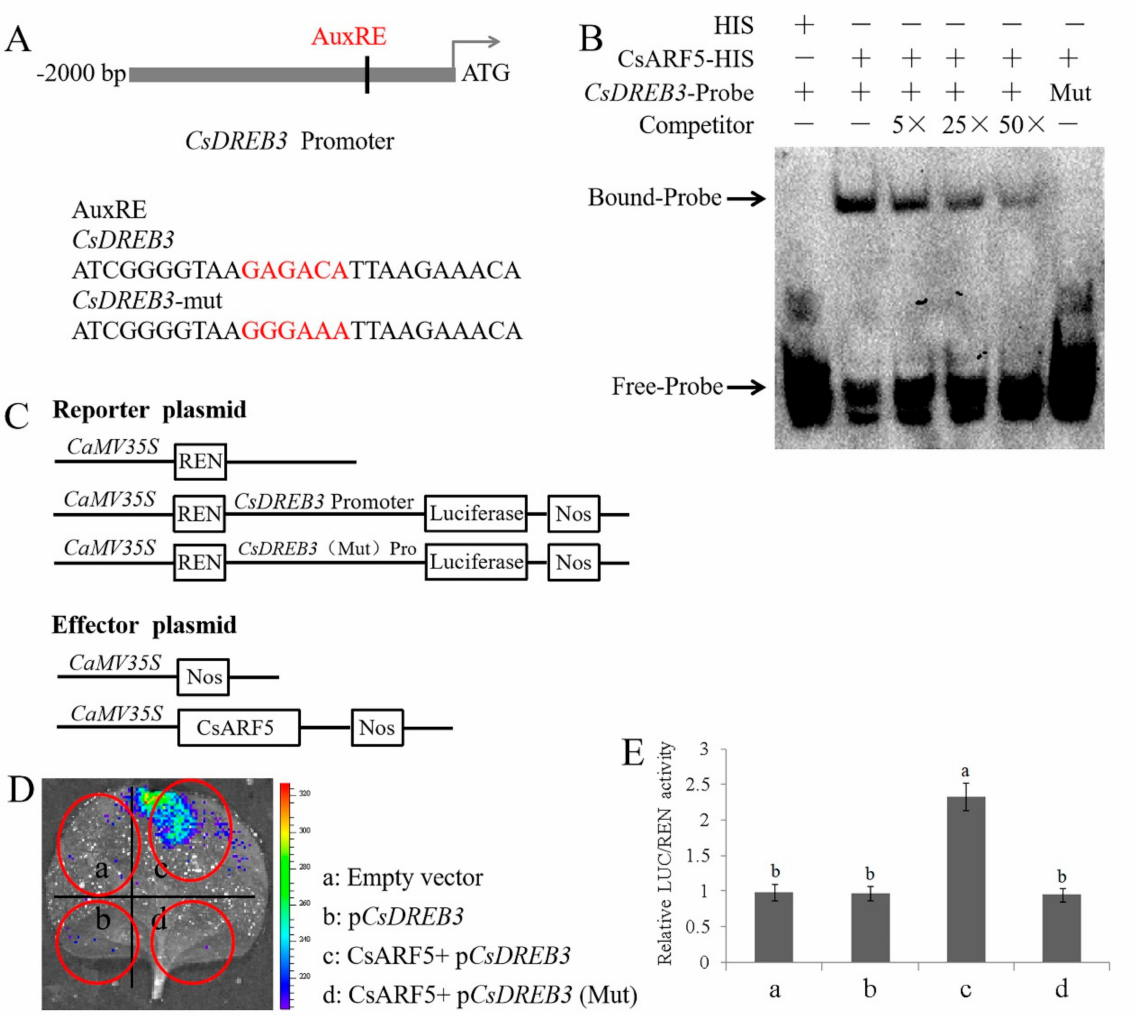
Figure 8. CsARF5 directly modulates the expression of CsDREB3 . ( A ) Schematic diagram showing the CsDREB3 promoter probe used for EMSAs. Mutated probe ( CsDREB3 -mut) in which the 5 (cid:48) -GAGACA-3 (cid:48) motif was replaced by 5 (cid:48) -GGGAAA-3 (cid:48) . ( B ) EMSAs show that CsARF5 binds to the MdDREB3 promoter. The experiments were repeated three times with similar results. A typical picture is shown here. ( C ) Schematic representation of the LUC reporter vector containing the CsDREB3 promoter and the effector vectors expressing CsARF5 under the control of the 35S promoter. ( D ) Dual luciferase tests in tobacco leaves showing that CsARF5 activates CsDREB3 transcription. Mutated promoter sequence (pCsDREB3-Mut) in which the 5 (cid:48) -GAGACA-3 (cid:48) motif was replaced by 5 (cid:48) -GGGAAA-3 (cid:48) . The experiments were repeated three times with similar results. A typical picture is shown here. ( E ) LUC/REN activity detection to verify that CsARF5 activates the transcription of CsDREB3 . Empty vector was used as the reference and set to 1. Error bars denote standard deviations. Different letters indicate significant differences ( p < 0.05) based on Duncan’s multiple range tests. All experiments were performed three times with similar results, and representative data from one repetition are